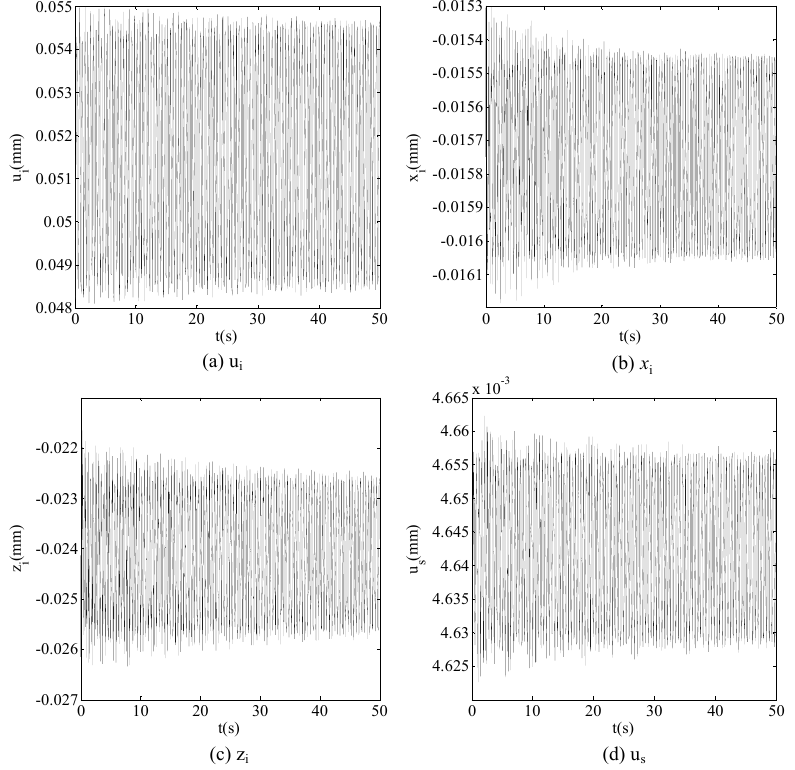
Fig. 7. The forced responses of the drive system to the dynamic eccentric center ( ω = 3000 rad/s). maximum (about 3.5 μ m). The amplitudes of the other vibrations x i and z i of the planet is the same orders of magnitude as the amplitude of the vibration u i . The amplitude of the rotational vibration u s is the smallest (about 0.02 μ m). It is because the exciting frequency 3000 rad/s is far from the natural frequencies of the drive